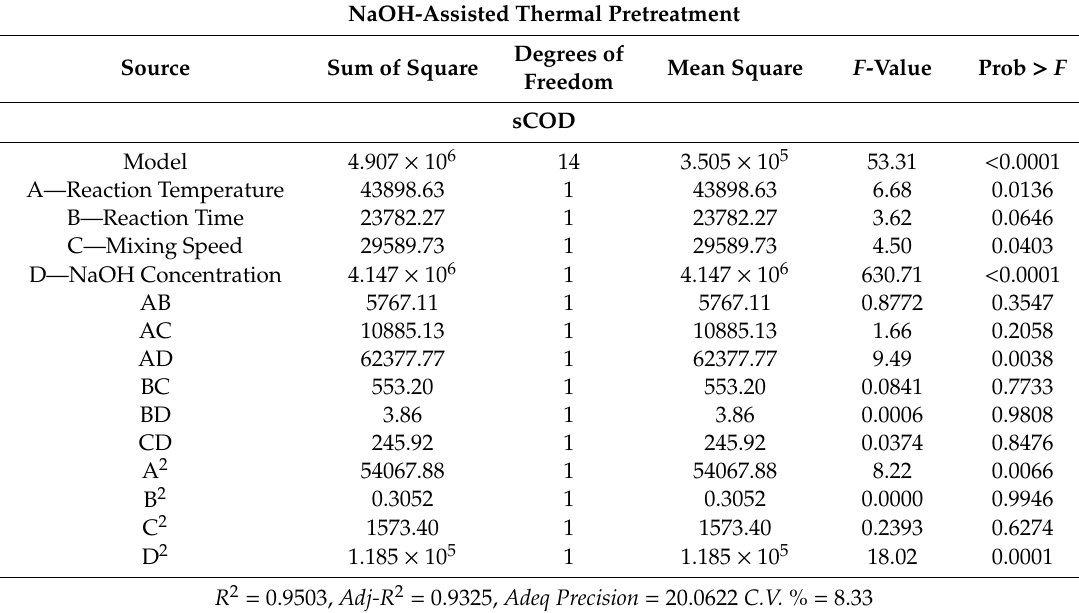
Table 3. ANOVA results for chemical-assisted thermal pretreatments for